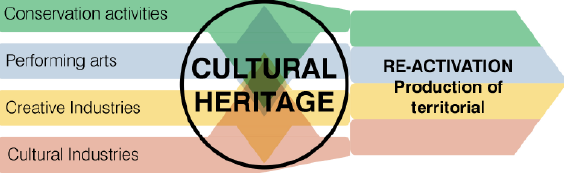
Figure 6. The upstream perspective on CH impact. Source: Cultural Heritage Counts for Europe – CHCFE,